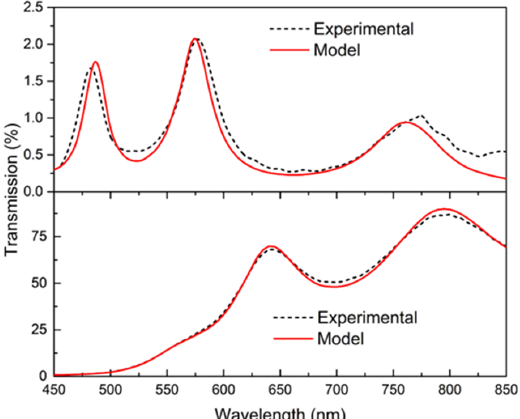
Figure 1. Spectral dependence of the transmission of the fabricated samples. Top graph, spectrum before exposure and bottom graph, spectrum after exposure. The experimental spectra are in black, and the spectra that were modeled using thin film models are in red.